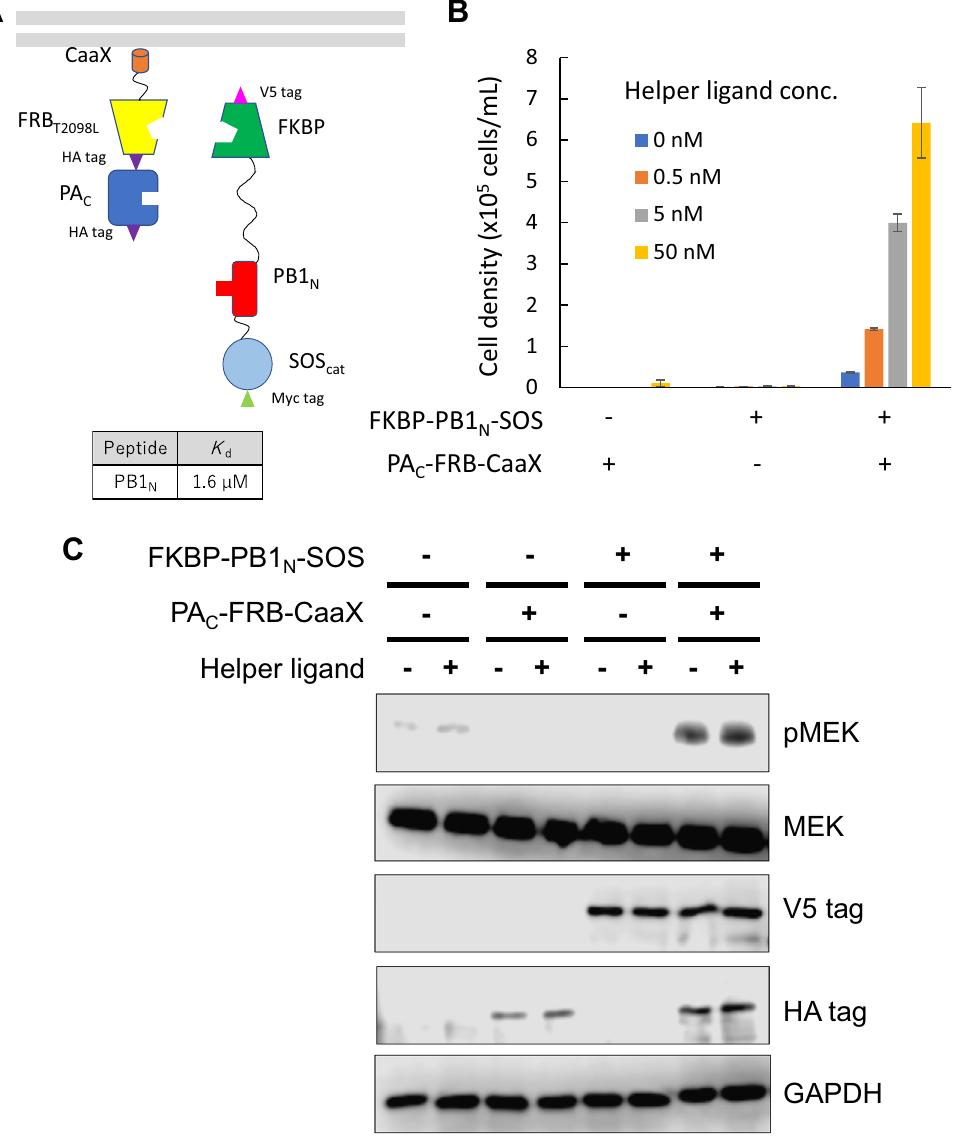
Figure 3. Detecting PA C –PB1 N interaction by H-SOLIS. ( A ) The design of the membrane-anchored and signaling chimeras incorporating PA C and PB1 N . The dissociation constant of PB1 N binding to PA C is also shown. ( B ) Cell growth assay. Cells were seeded at 1 × 10 5 cells/mL and cultured for 3 days in the medium with the indicated concentrations of the helper ligand AP21967. Viable cell densities are shown as mean ± SD (n = 3, biological replicates). ( C ) Signaling analysis. Cells were stimulated for 15 min with or without 50 nM of the helper ligand AP21967. Phospho-MEK, whole MEK, V5 tag (FKBP-PB1 N -SOS expression), HA tag (PA C -FRB- CaaX expression), and GAPDH (loading control) were detected using corresponding primary antibodies. Uncropped blot images are provided in Supplementary Fig.